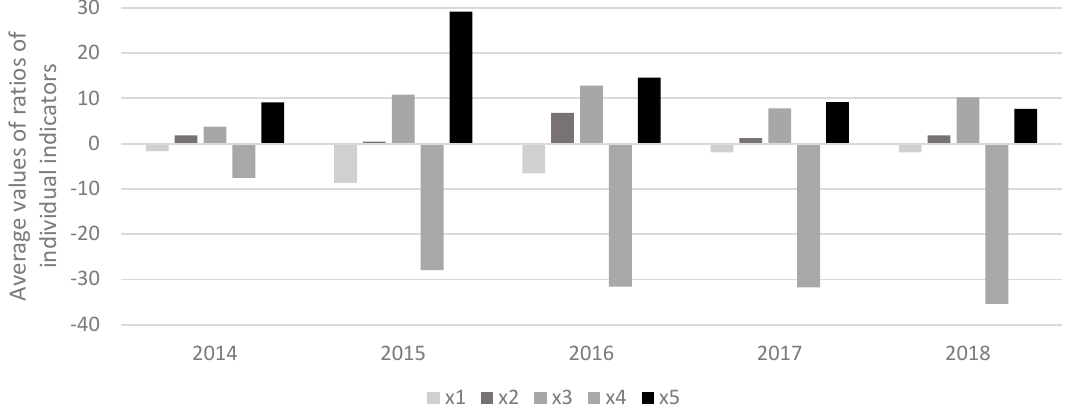
Figure 6. Average values of Altman Z-score variables.